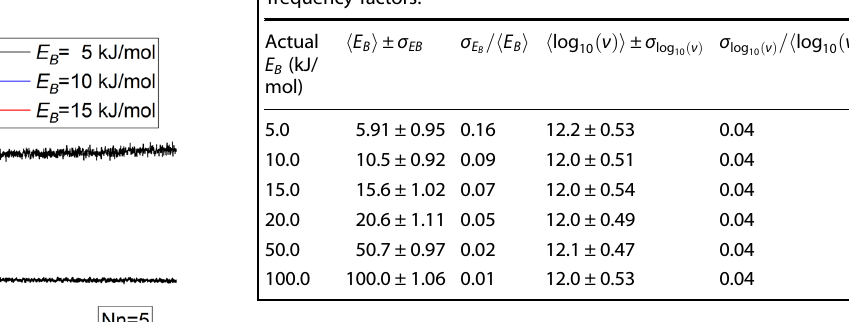
Fig. 2 Evolution of the crystal geometry during dissolution. Images ( a ) and ( c ) for E B = 5 kJ/mol and ( b ) and ( d ) for E B = 15 kJ/mol. Images ( a ) and ( b ) correspond to a reaction advancement of 10%, and images ( c ) and ( d ) to 50%. Only 1/8 of the crystal is represented. The white solid line is the initial size of such a one eight of the crystal. Table 3. Parameter estimation results for activation energies and frequency